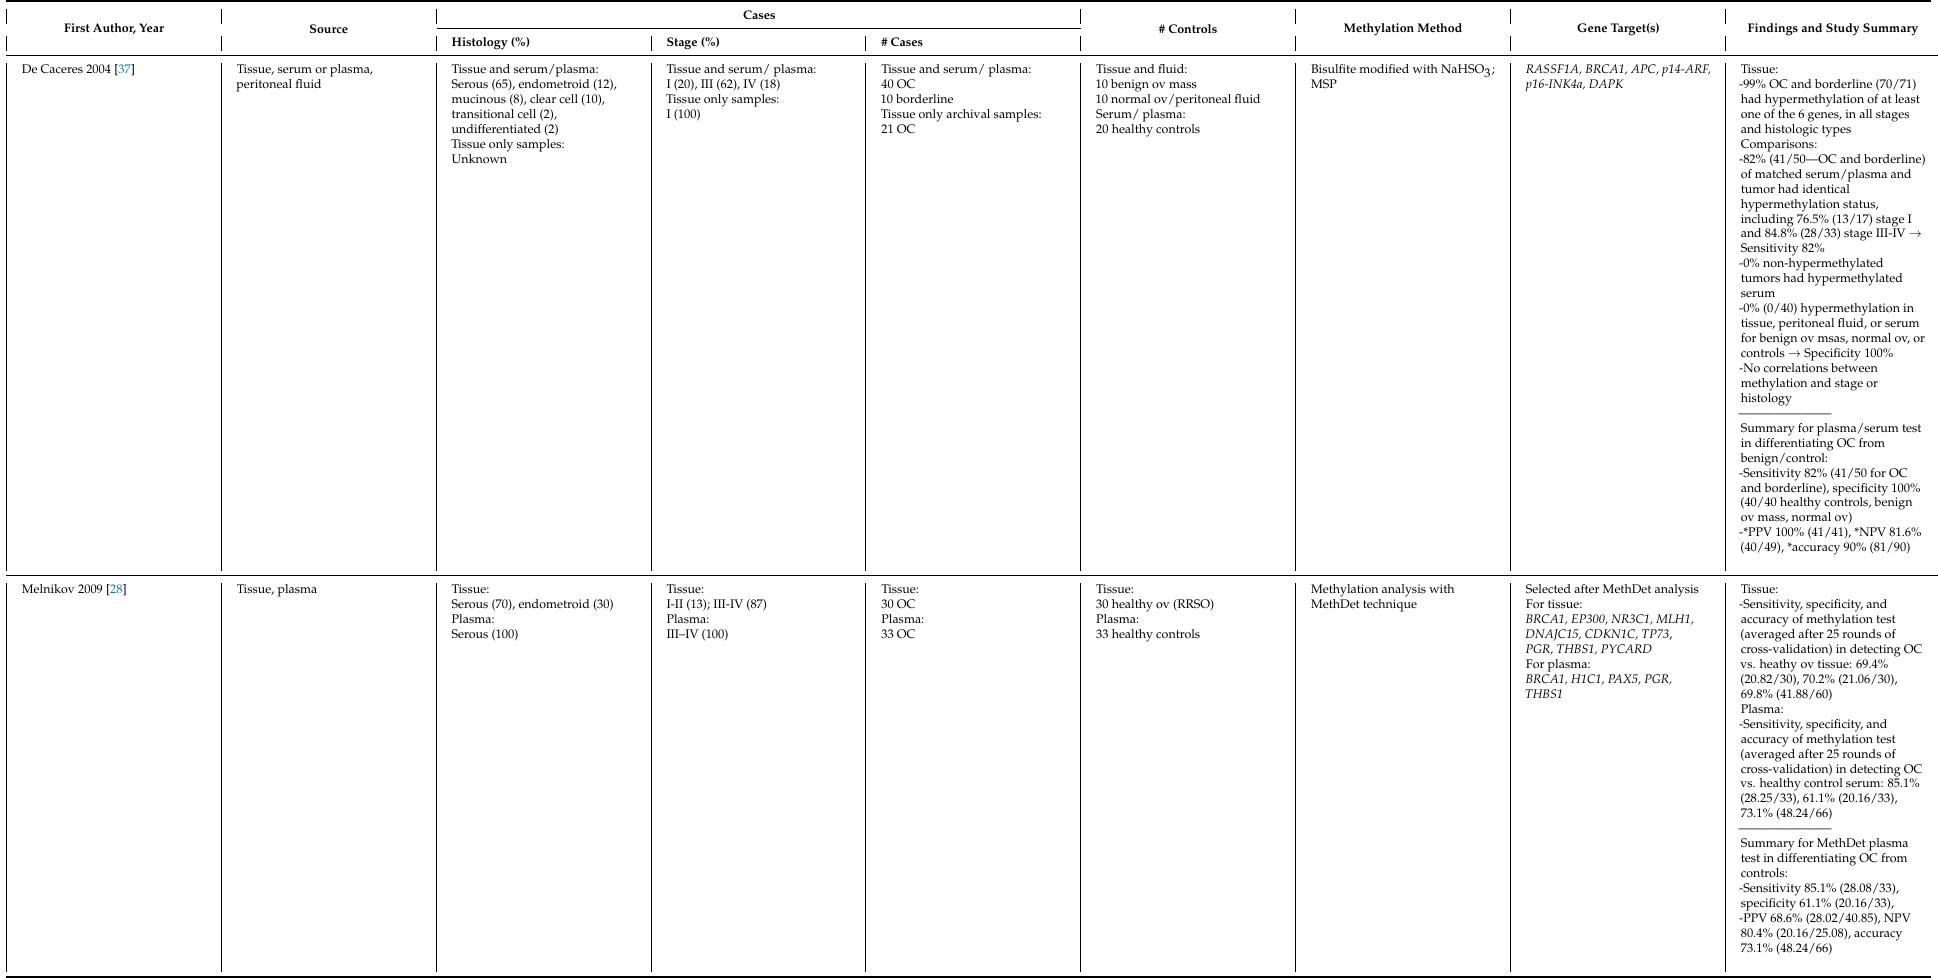
Table 1. Summary of included literature review